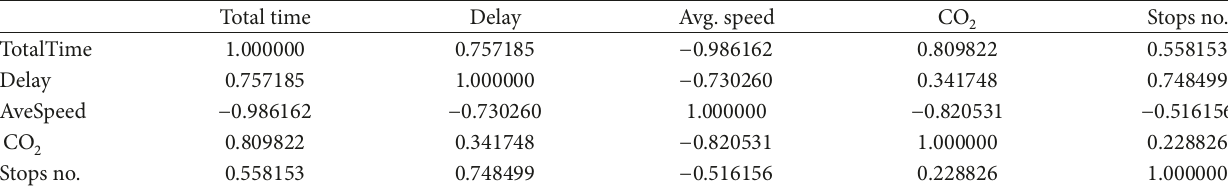
Figure 6: Scatter plots for each pair of the results for both scenarios, showing the relationships between each pair of variables. The diagonal (the relationship between a variable and itself) represents the histogram of the variable on its own domain. Table 2: Correlation matrix between the monitored indicators in Scenario 1.